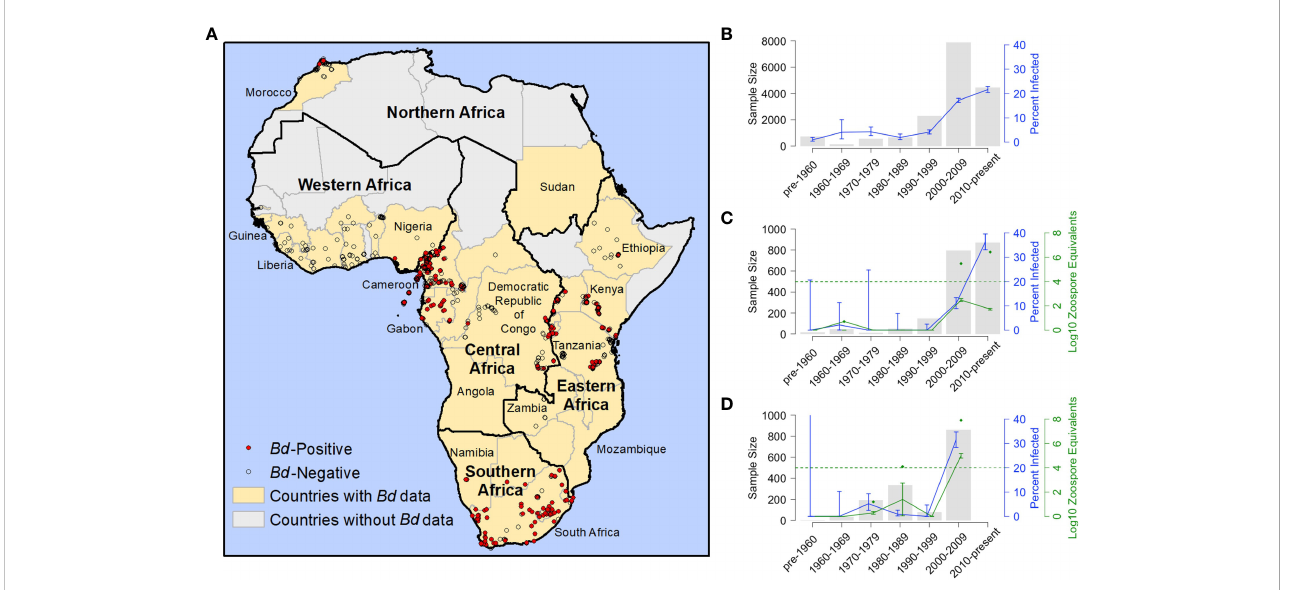
FIGURE 1 Distribution and frequency Batrachochytrium dendrobatidis (Bd) occurrence in Africa 1852-2017. (A) Georeferenced Bd survey data for Africa (N=11,472; includes records generated for this study and previously published records for which we had latitude and longitude); red dots indicate Bd -positive records (N=1,914); open circles indicate Bd -negative records (N=9,558); yellow fi ll indicates countries with Bd data (including georeferenced and non- georeferenced locations); black outlines indicate regions, as de fi ned by the United Nations; (B) frequency of Bd occurrence for all of Africa by decade; N=16,686 (171 samples included in Table 1 not included here because collection years did not fall into a single decade); (C) frequency of Bd occurrence and infection intensity results from Cameroon; N=1,940 [includes our data records generated for this study, records from Hirschfeld et al. (2016) and from Zimkus et al. (2020)]; (D) frequency of Bd occurrence and infection intensity results from Kenya; N=1,503 [records through 1999 generated for this study; 2006 records from Kielgast et al. (2010)]; (B – D) grey bars represent sample size (N); blue line represents frequency of occurrence (percent infected) and blue bars represent the corresponding 95% binomial con fi dence intervals (95% CI); (C, D) green line represents the average infection intensity (the logarithm of zoospore equivalents or logZE) and green bars represent the corresponding standard error; green diamonds represent maximum logZE for each time period; green hashed horizontal line indicates a logZE value of 4, the threshold for deadly infection intensity (Vredenburg et al., 2010; Kinney et al.,